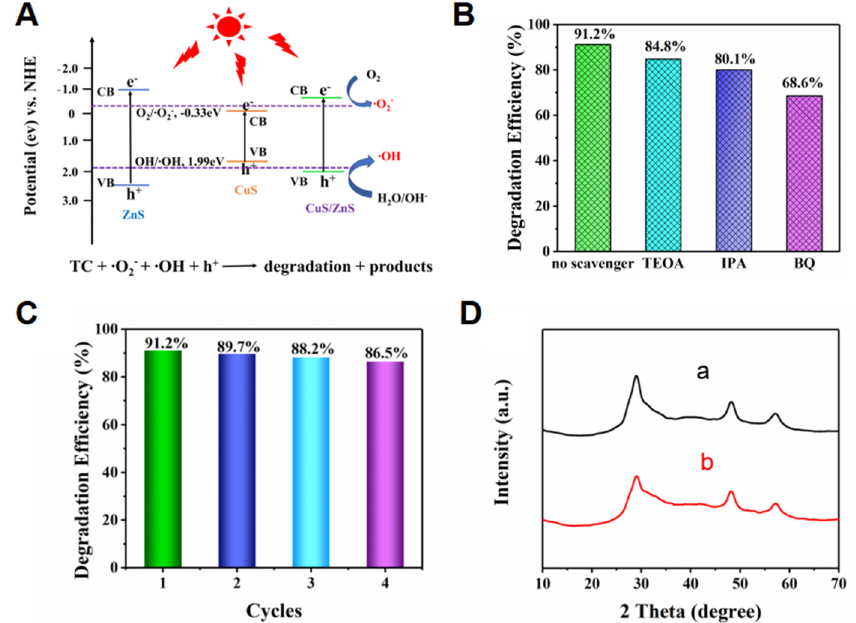
Figure 6. ( A ) Photocatalytic degradation mechanism of the CuS/ZnS nanocomposite for TC; ( B ) free radical capture level of the CuS/ZnS nanocomposite; ( C ) degradation rates of TC by the CuS/ZnS nanocomposite after multiple reuse; ( D ) XRD spectra of the CuS/ZnS nanocomposite before (a) and after (b) reuse.